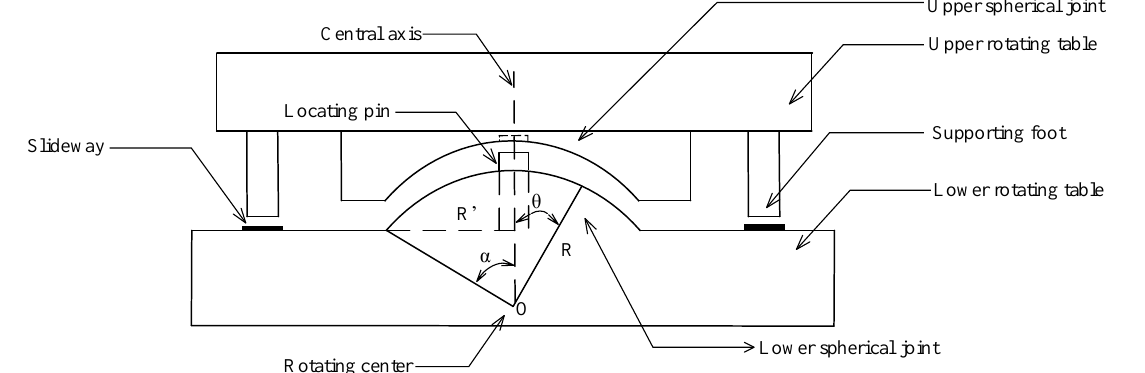
Figure 15. Resistance system of the overturning moment. R is the radius of spherical joint; R’ is the